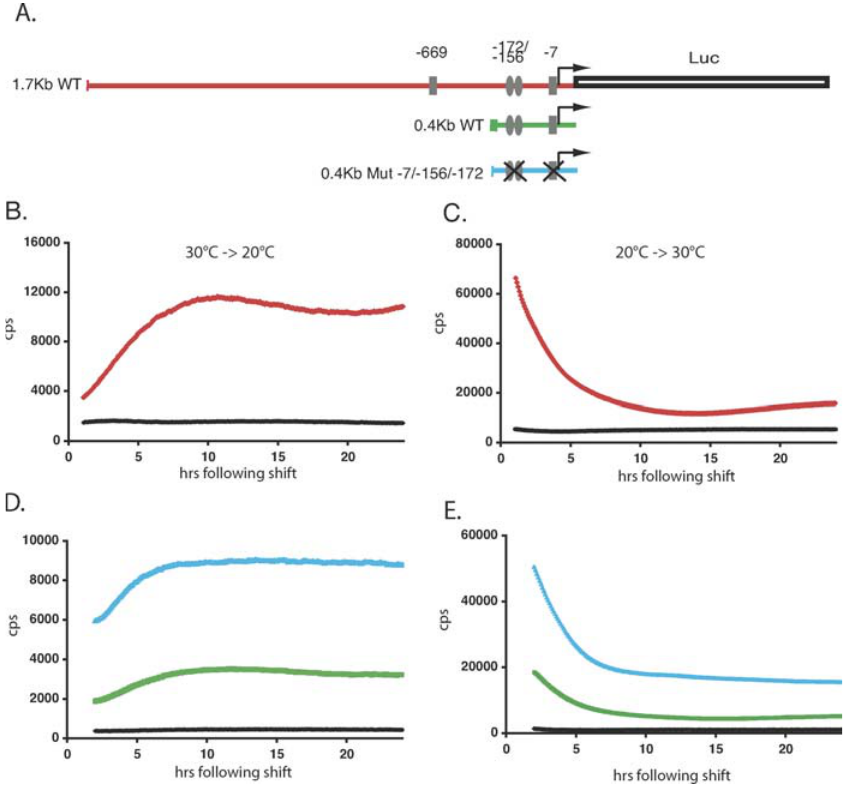
Figure 4. Temperature Steps Induce Changes in per4 Gene Transcription (A) Schematic representation of the 1.7-kb WT (red), 0.4-kb WT (green), and the 0.4-kb Mut (cid:1) 7/ (cid:1) 156/ (cid:1) 173 (blue) per4 promoter luciferase reporter constructs. E-box elements are represented by rectangles (CACGTG) and ellipses (AACGTG), and their positions relative to the principal transcription start site are labeled. E-boxes that have been ablated by mutation to the sequence (CTCGAG) are shown by a cross [27]. (B) Bioluminescence from PAC-2 cells stably transfected with the 1.7-kb WT construct adapted to 30 8 C and then shifted rapidly to 20 8 C (red trace). During the entire assay, the plate was held inside the Topcount counting chamber, and each well was counted for 3 s at intervals of approximately 5.5 min. Bioluminescence (counts per second) is plotted against time (h) following the temperature shift. A black trace represents pGL3Control transfected cells bioluminescence. (C) Equivalent experiment to that in panel B, with cells adapted to 20 8 C and shifted to 30 8 C. (D and E) Cells transfected with the 0.4-kb WT and 0.4-kb Mut (cid:1) 7/ (cid:1) 156/ (cid:1) 173 constructs were subjected to the same rapid temperature decrease and increase, respectively, as described for (B) and (C). All traces represent the mean values of 16 independent wells. Each panel is representative of at least three independent